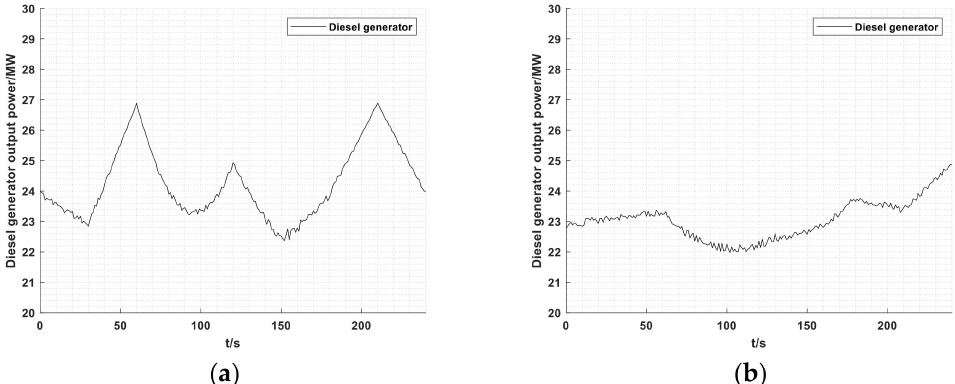
Figure 14. Output curve of the diesel generator. ( a ) When wind-photovoltaic-energy storage out- put fluctuates relatively violently. ( b ) When wind-photovoltaic-energy storage output fluctuates relatively gently.